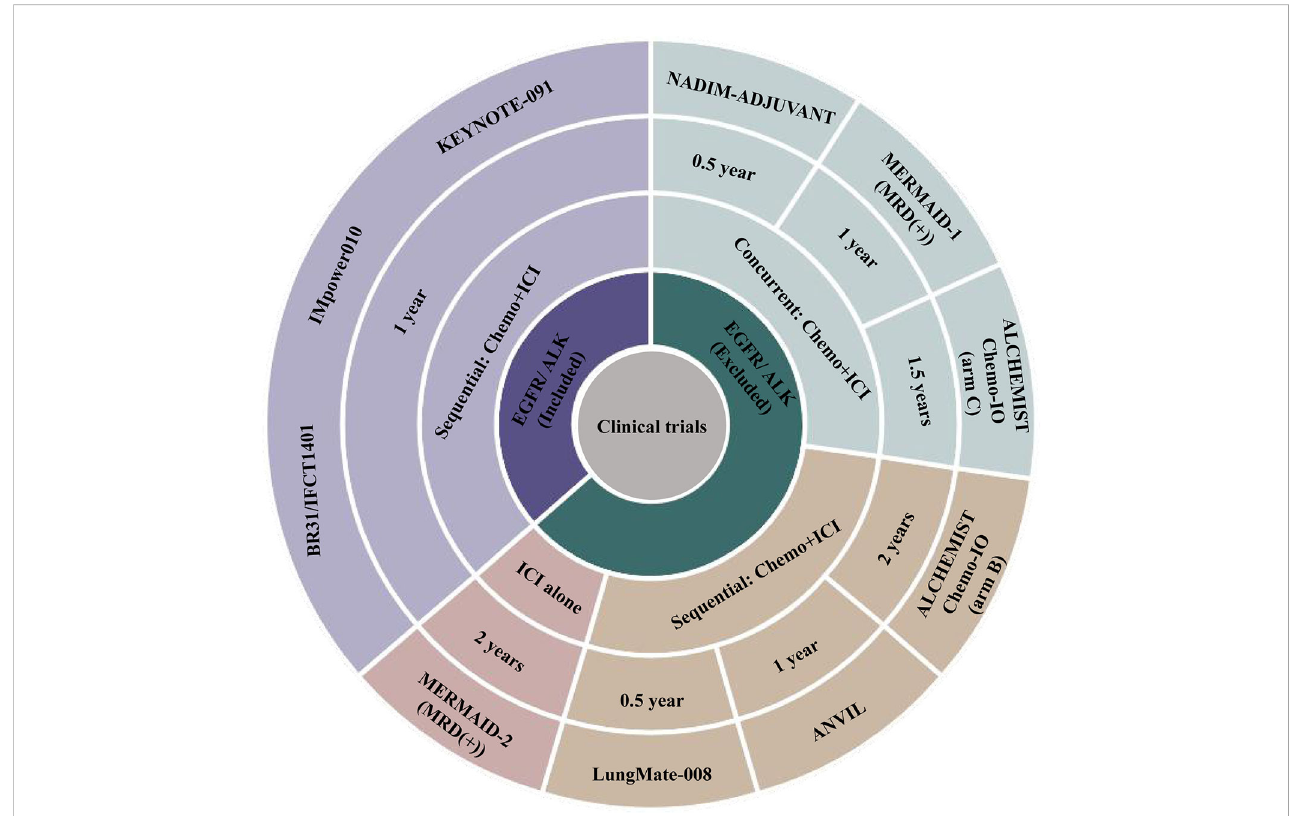
FIGURE 2 Summary of ongoing adjuvant immunotherapy clinical trials. ALK, anaplastic lymphoma kinase; Chemo, chemotherapy; EGFR, epidermal growth factor receptor; ICI, immune checkpoint